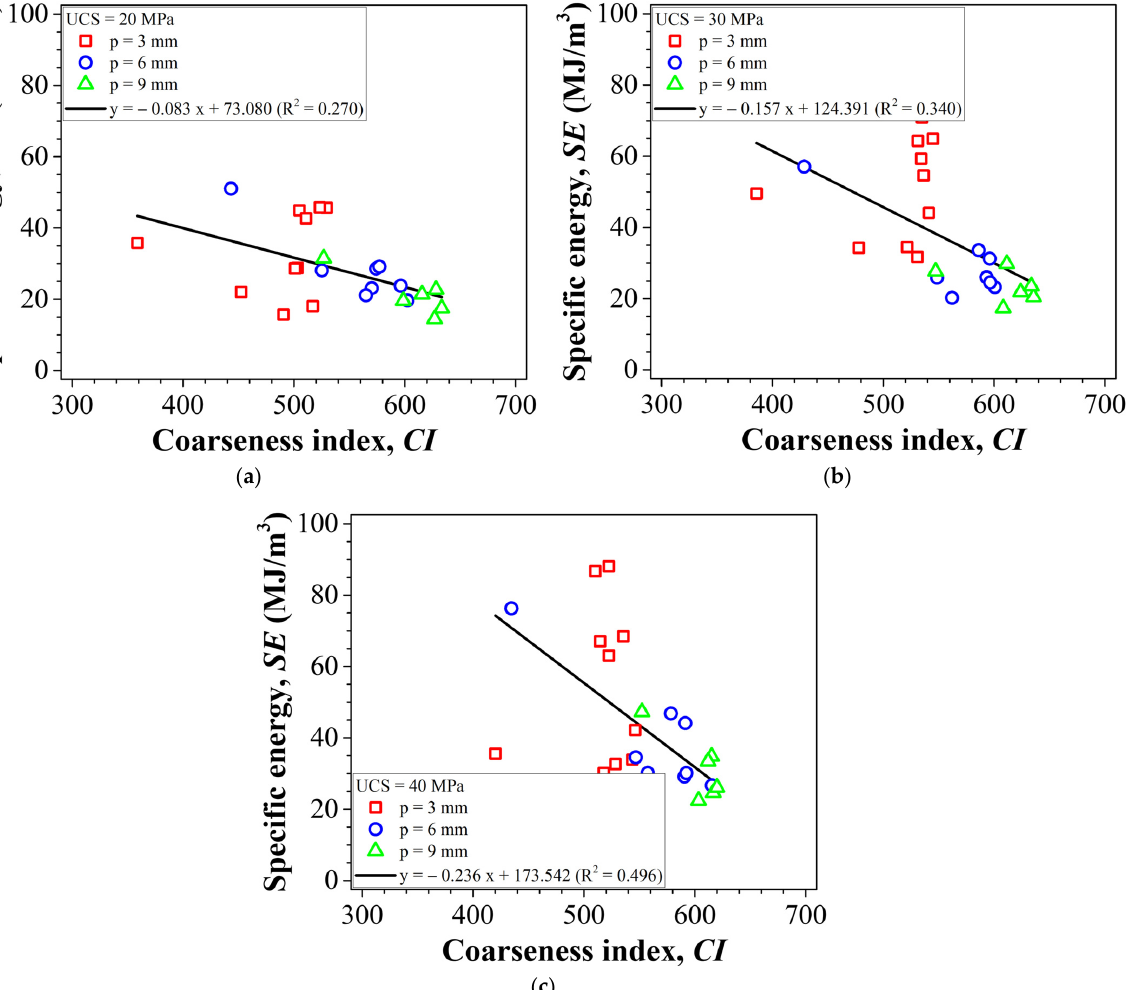
Figure 15. Relationship between CI and SE : ( a ) rock of UCS 20 MPa; ( b ) rock of UCS 30 MPa; ( c ) rock of UCS 40 MPa.